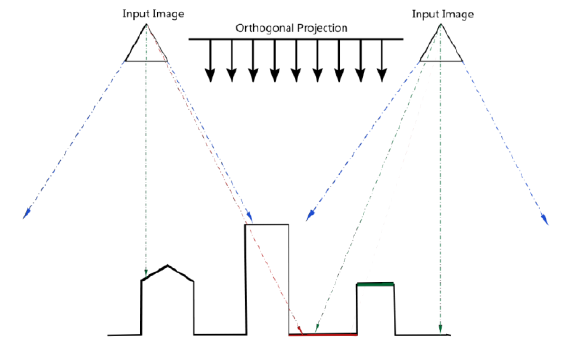
Figure 2 Concept of an ortho projection with two input